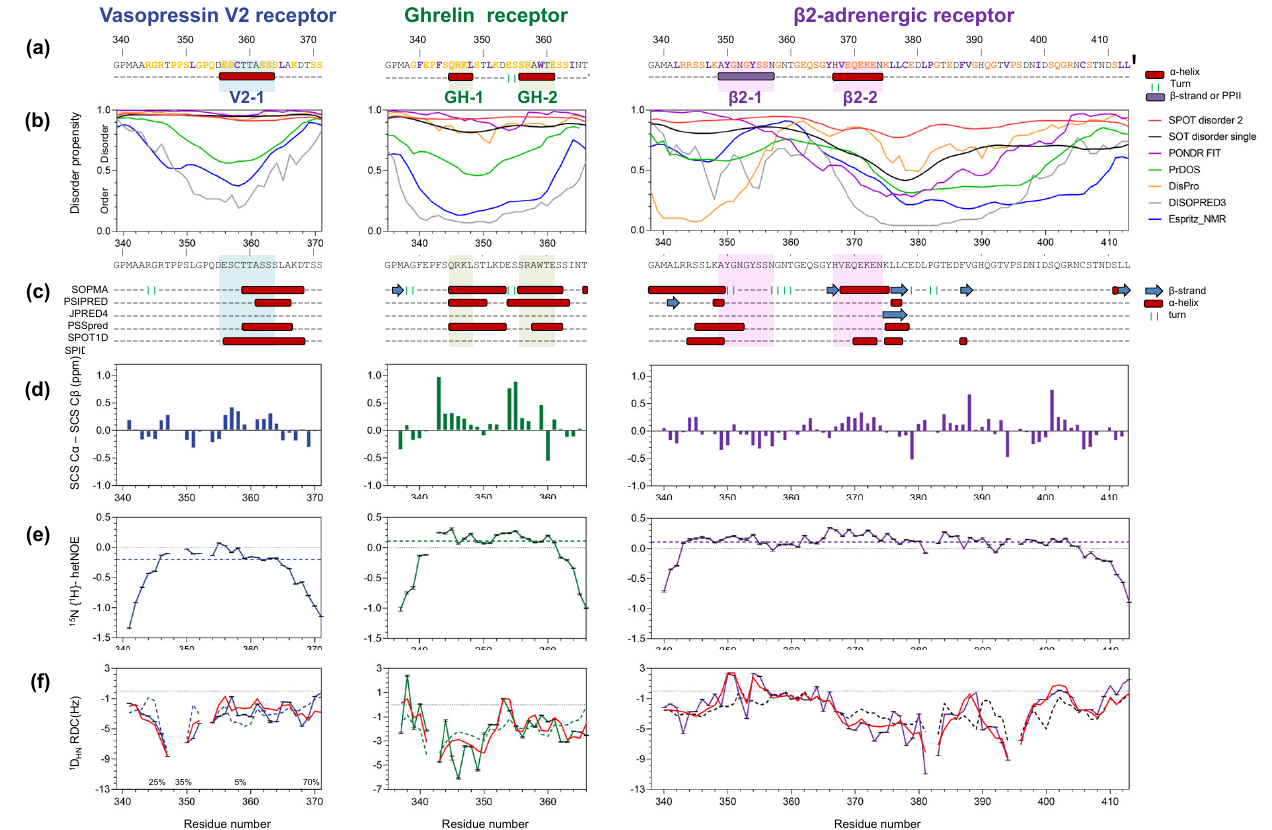
Figure 3. Bioinformatics predictions, secondary structure propensity, backbone dynamics, and RDC conformational profile of the disordered V2R-Cter (blue), GHSR-Cter (green), and β 2AR-Cter (purple) . ( a ) GPCR C-termini are composed of more than 50% disorder-promoting residues (in orange). Ordered-promoting residues are indicated in purple. Secondary structures obtained by the consensus of all NMR data are indicated under the sequence and highlighted according to their respective color code. Helix, β -strand, extended conformation ( β -strand or polyproline helix 2, PPII), and turns are represented as red cylinder, blue arrow, purple box, and green bars, respectively; ( b ) disorder prediction by SPOT-Disorder 2 (red), SPOT-Disorder Single (black), PONDR-FIT (purple), PrDOS (green), DisPro (orange), DISOPRED 3 (grey), and Espritz-NMR (blue). The disorder/order threshold (0.5) is indicated in black line; ( c ) secondary structure prediction by SOPMA, PSIPRED, JPRED4, PSSpred, SPOT 1D, and SPIDER 3 web-servers are represented for helices (red cylinder), strands (blue arrow), and turns (green); ( d ) computed secondary structure SCS C α -SCS C β using random coil chemical shifts from POTENCI; ( e ) heteronuclear 15 N{ 1 H}-NOEs are represented with colored curves and the average with dash colored lines; ( f ) back-calculated and experimental 1 D HN RDCs. Comparison of experimental RDC (colored according to the GPCR-Cter color code) and back-calculated values computed with FM on a random-coil ensemble (dash color line) and biased ensemble (red line) and populated as indicated in the figure for helical structure (highlighted in red), extended structure (highlighted in blue), or turn (highlighted in green). Spectra were recorded at 700 MHz and 20 ◦ C, in 50 mM Bis-Tris pH 6.7, 150 mM NaCl